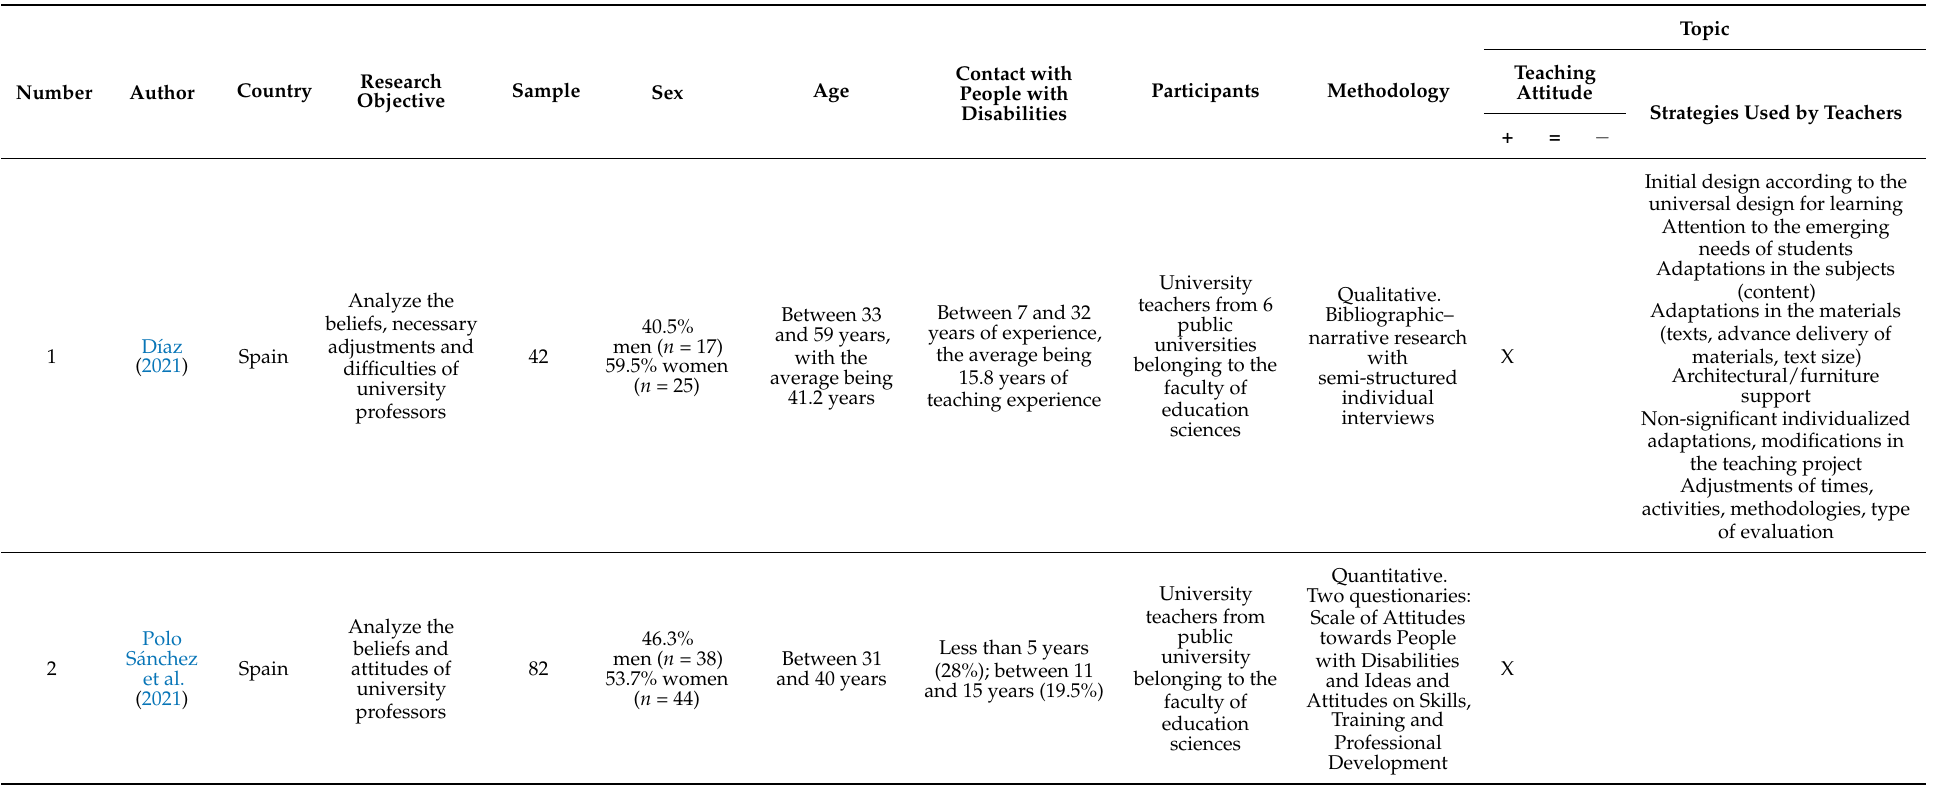
Table 2. General distribution of the selected